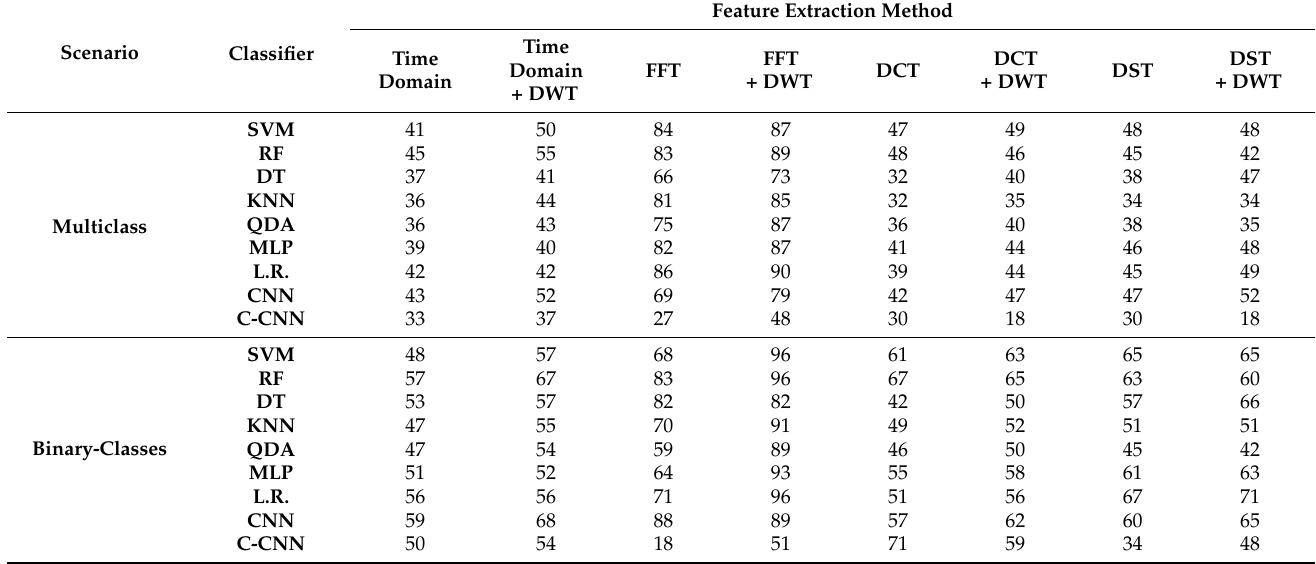
Table 4. Brief Comparison among The Recall of The Proposed Machine Learning Models in Differ- ent